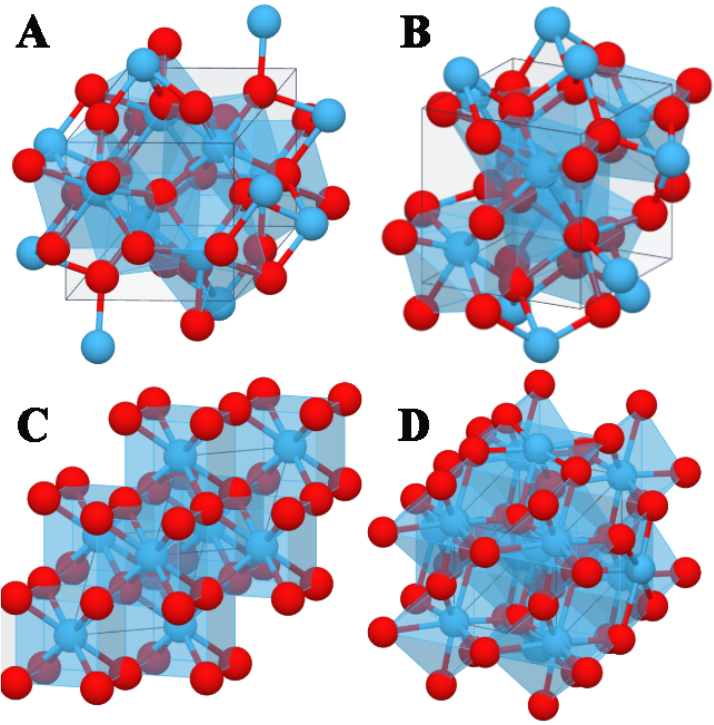
Figure 1. atomic structures of single domains of monoclinic ( A ), orthorhombic ( B ), cubic ( C ), and tetragonal ( D ) HfO 2 polymorphs. Hf and O atoms are reported in light blue and red spheres, respectively.